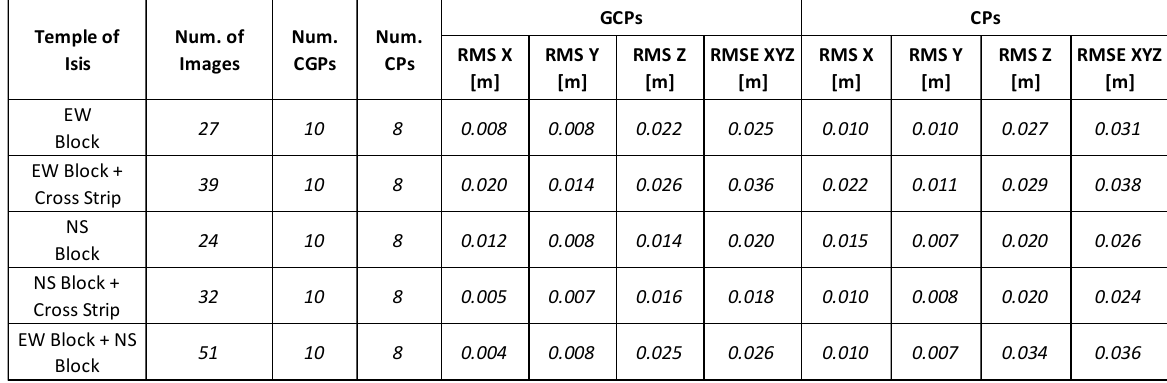
Table 3. The statistical parameters resulting from the images orientation for dataset of the Temple of Isis